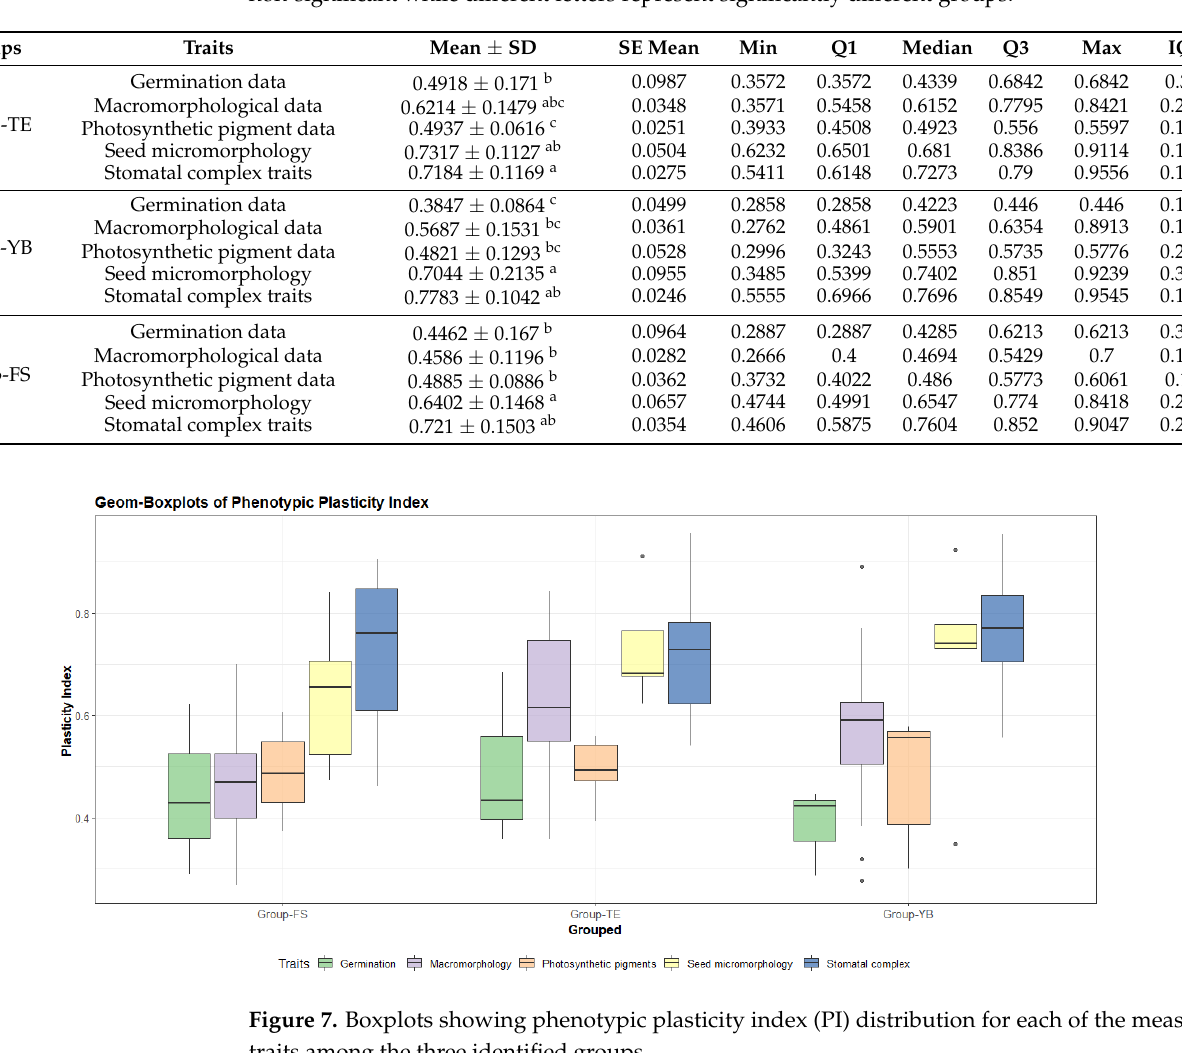
Table 5. Descriptive statistics of the plasticity index (PI) for the studied traits, showing pairwise comparisons among the three groups of Trianthema portulacastrum . Groups that share same letters are non-significant while different letters represent significantly different groups.